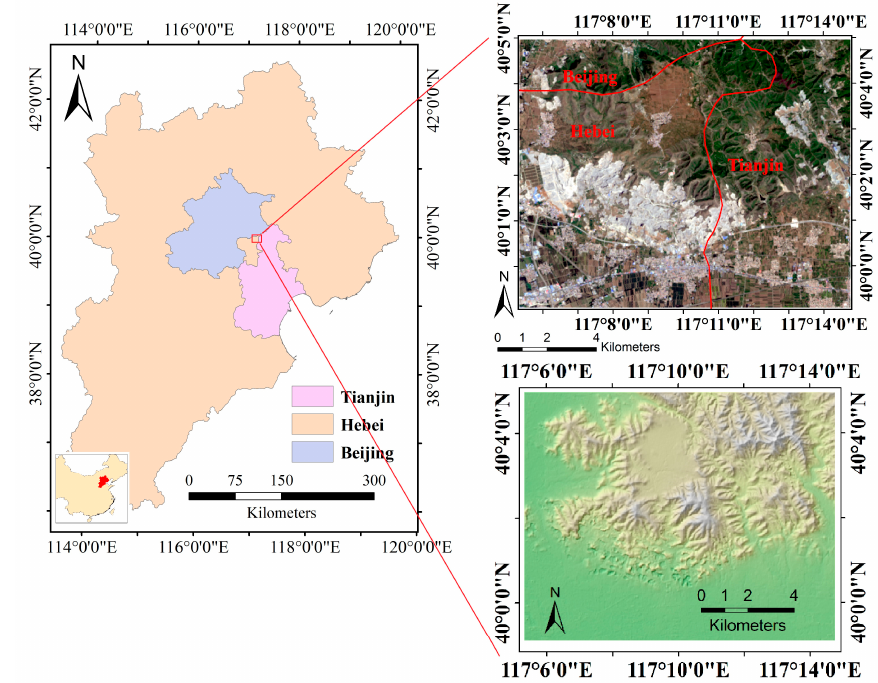
Figure 1. Study area located at the boundary of Beijing, Tianjin, and Hebei; the upper left image is the Landsat imagery in 2016 depicting severe damage to the mountain body caused by mining activities; the lower left image is a digital surface model (DSM) map of the study area. Data comes from Advanced Land Observing Satellite (ALOS) DSM. (http://www.eorc.jaxa.jp/ALOS/en/aw3d30/data/index.htm).